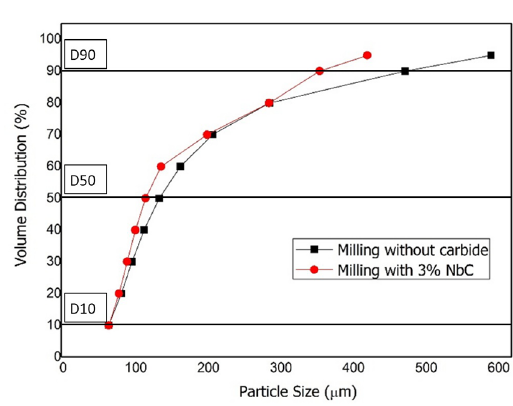
Figure 5. Volumetric distribution as a function of the particle size of the milling with and without addition of the NbC. spots represent the niobium because of the higher atomic weight of niobium. Figure 6b shows the chemical elements